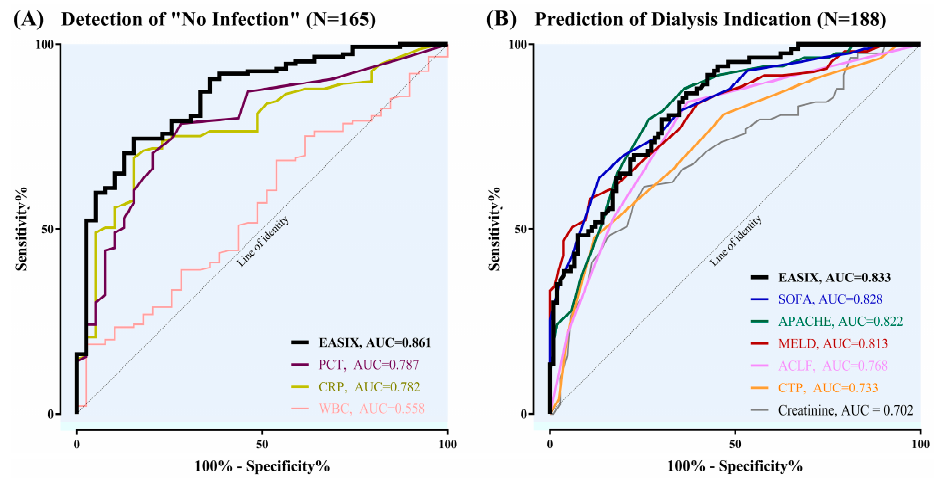
Figure 4. Diagnostic ability of baseline EASIX. ( A ) Diagnostic ability of baseline EASIX to rule out clinically overt infections (“ No Infection ”) on ICU admission in comparison with PCT, CRP and WBC. ( B ) Predictive value of baseline EASIX compared with common clinical scores in identifying patients requiring hemodialysis therapy during their ICU stay.